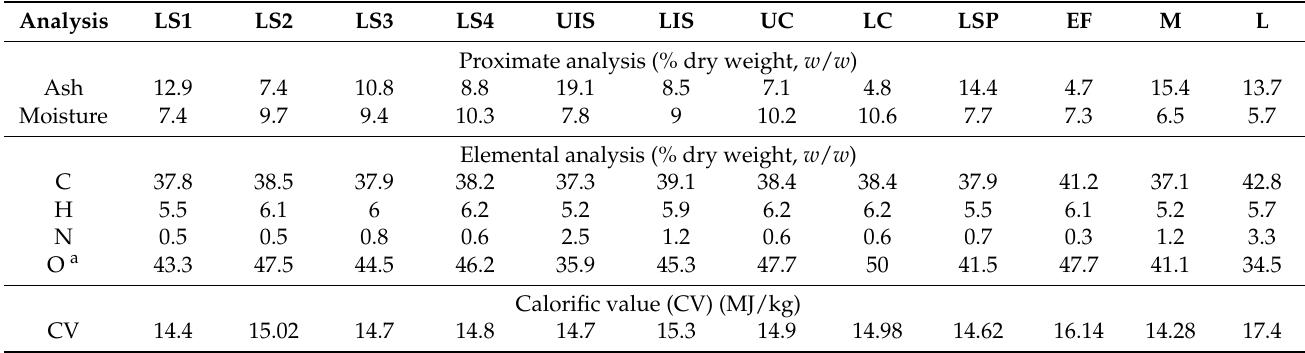
Table 1. Proximate and elemental analysis results for Enset biomass parts.